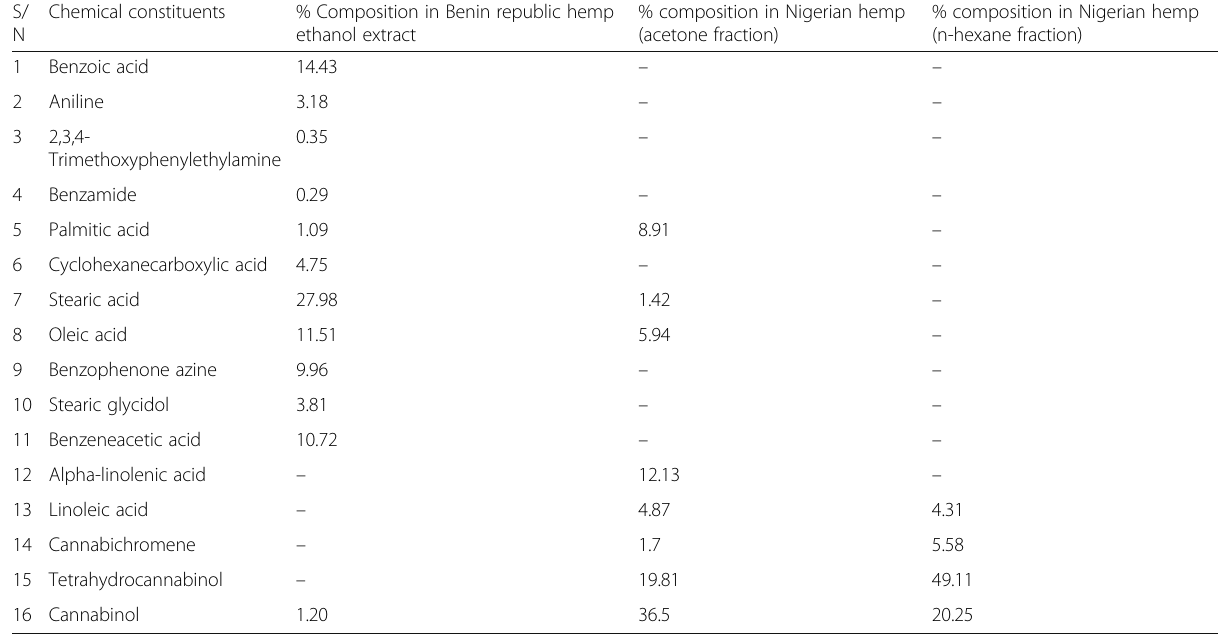
Table 1 Organic composition of hemp samples revealed by